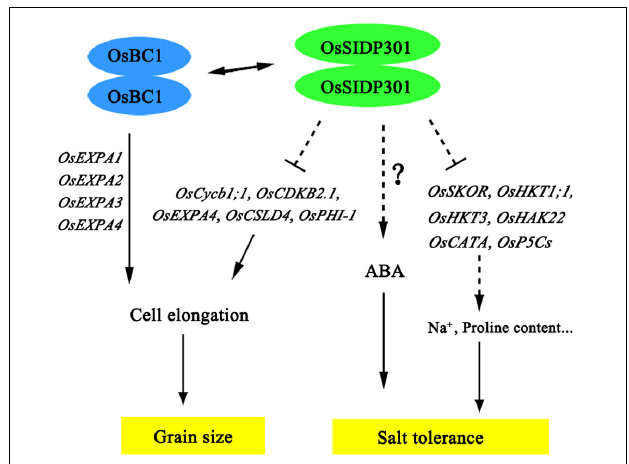
FIGURE 10 | The proposed working model of OsSIDP301 regulates salt tolerance and grain size. The dotted lines indicated indirect regulation, the two-way arrows indicate interaction of protein, and the solid lines indicate direct